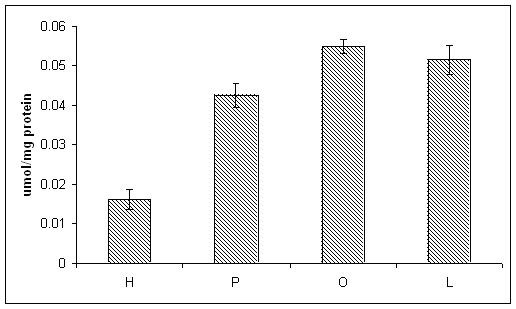
Intracellular TG accumulation. Intracellular TG accumulation increased in FFA treated cells. * significantly higher than control, p < 0.01 by t-test. H: control, P: palmitate treatment, O: oleate treatment, L: linoleate treatment.